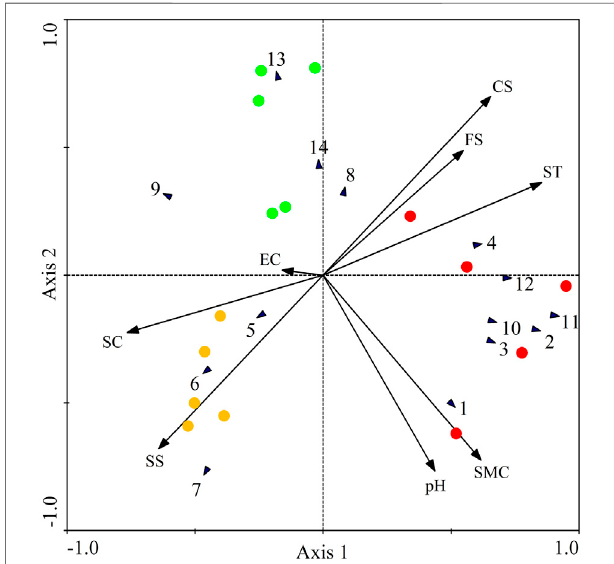
FIGURE 4 | Redundancy analysis (RDA) ordination diagram of soil microarthropod taxa with seasonal changes. Green, red, and yellow circle represented the spring summer autumn seasons, respectively. Black arrows represented soil microarthropod taxa, and red arrows represented environmental factors. Soil microarthropod taxa: 1 = Tenerif fi idae, 2 = Macrochelidae, 3 = Cryptopalmites, 4 = Pygmephoridae, 5 = Enocaligonellidae,6=Stigmaeidae,7=Tydeidae,8=Bdellidae,9=Oppiidae, 10 = Tetranychidae, 11 = Isotomidae, 12 = Onychiuriclae, 13 = Tomoceridae, 14 = Coleoptera Larvae. Environmental factors: SMC = soil moisture content, EC = electrical conductivity, SC = soil clay, SS = soil silt, FS = fi ne sand, CS = coarse sand, ST = soil